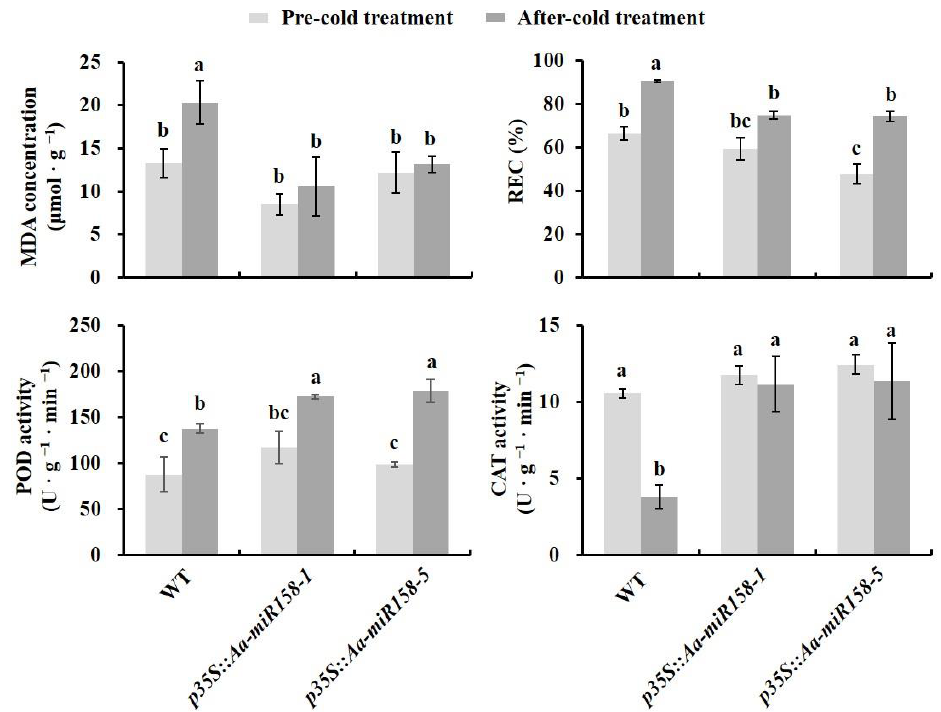
Figure 6. Statistical analyses of malondialdehyde (MDA) concentration, relative electrical conduc- tivity (REC), and activity of peroxidase (POD) and catalase (CAT) in leaves of p35S::pre-Aa-miR158 transgenic and WT lines under cold stress. Error bars represent standard deviations ( n = 3). Within each graph, values marked with the different letter are significantly different ( p < 0.05, Student ’ s t - test).